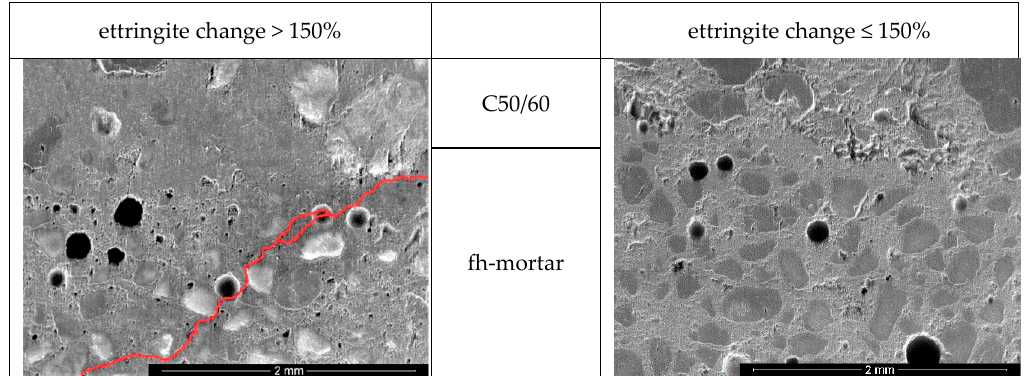
Figure 7. Characteristic ESEM pictures of samples with an 24 h ‐ ettringite change of >150% and ≤ 150% (crack is marked).